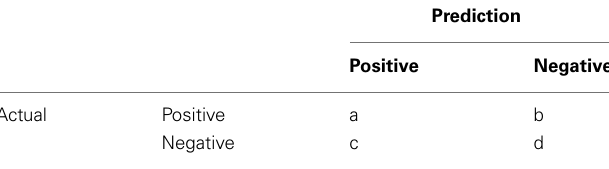
Table 1 |Two-class confusion